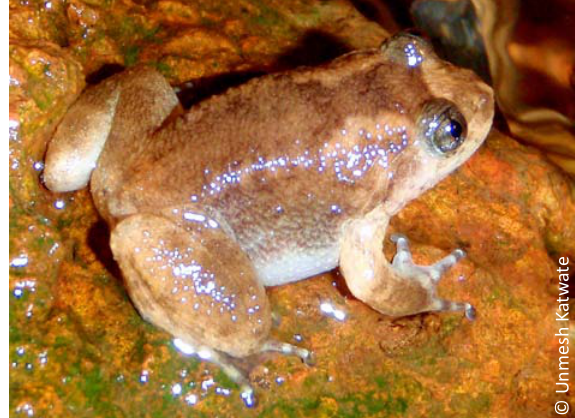
Image 8. Nyctibatrachus humayuni